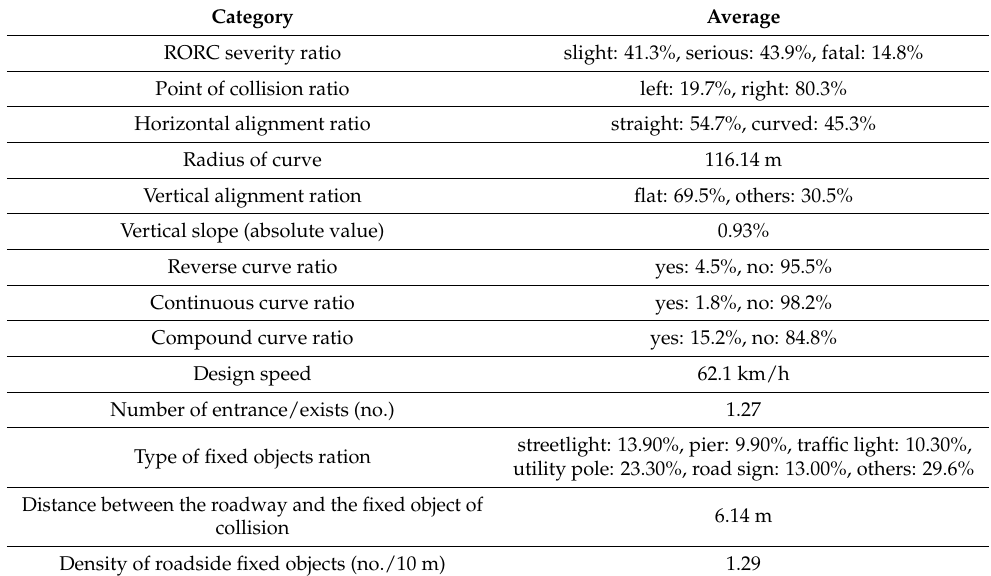
Table 1. Descriptive statistics of target